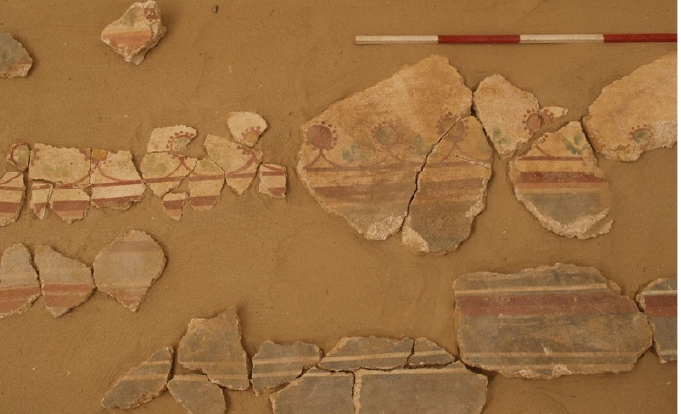
Figure 12. House H2, wall painting with floral motifs (photo Piotr Zambrzycki).